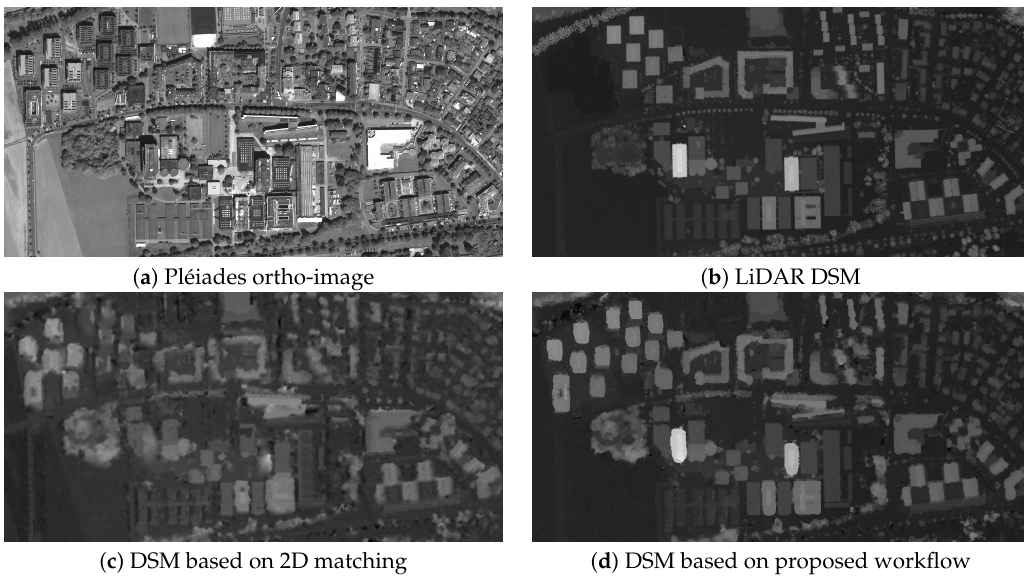
Figure 20. Detail view of an urban area at the Innsbruck stereo test site.